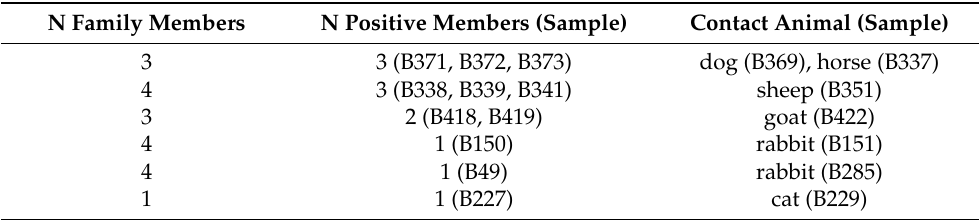
Table 5. Overview of families including individuals colonized by Dientamoeba fragilis as well as D. fragilis -positive animals with which these families were in close or frequent contact (N family members—total number of family members; N positive members—number of family members colonized with D. fragilis ; contact animal—animals colonized by D. fragilis which were in close contact with family